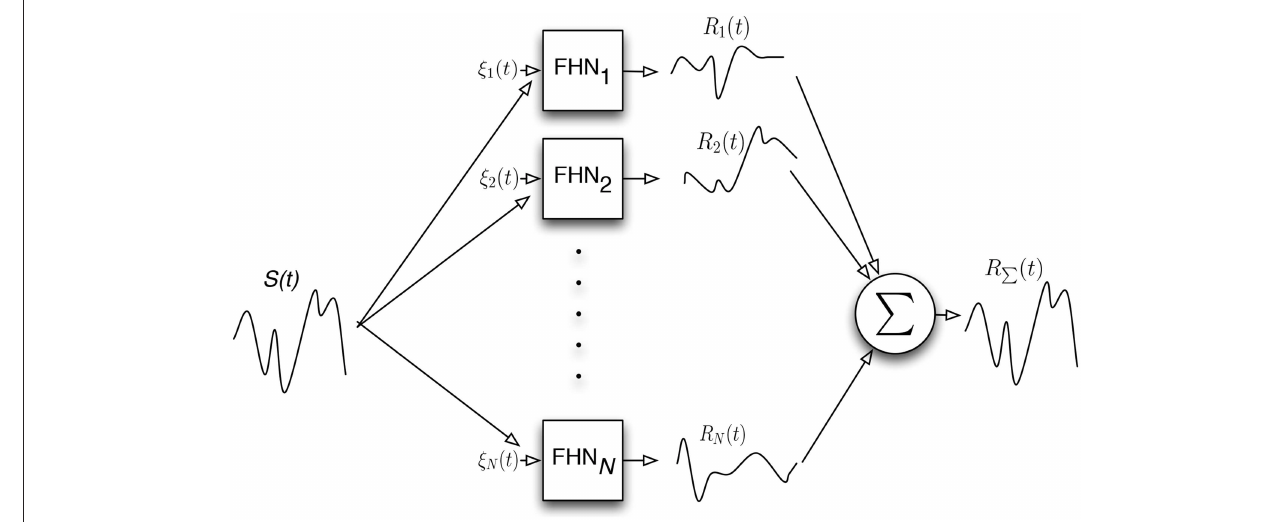
FIGURE 2 | Summing network of N FHN units. Figure adapted with permission from Collins et al.